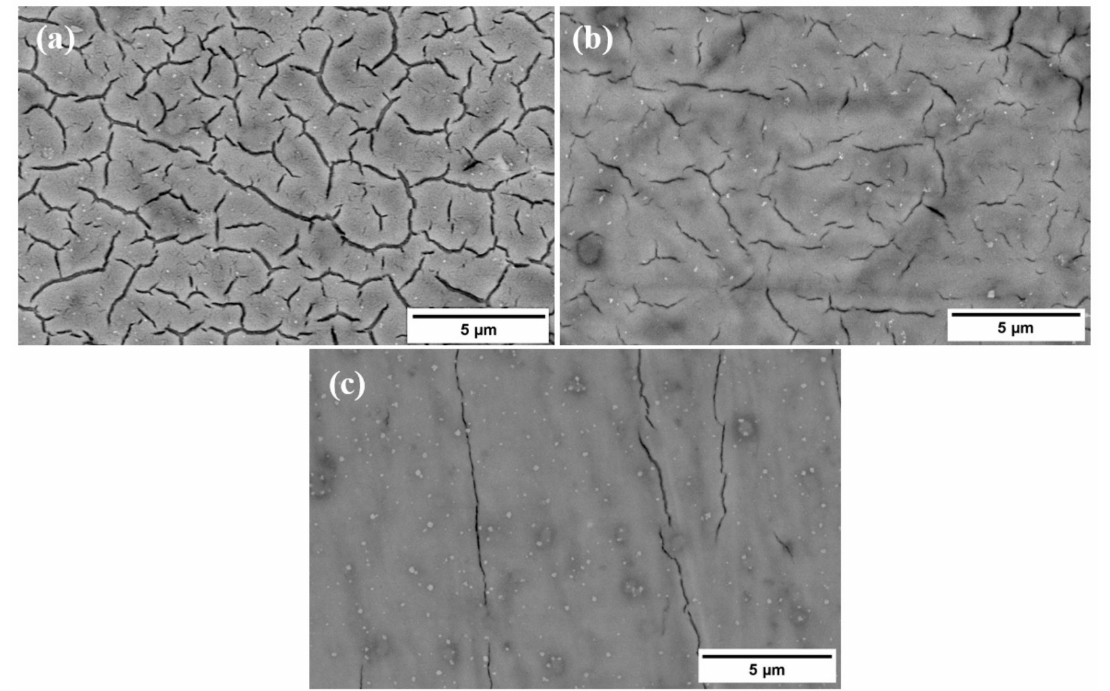
Figure 6. Microstructure of Ti-xTa substrates treated with 10 M NaOH at 20 k magnification—( a ) Ti-5%Ta; ( b ) Ti-15%Ta; ( c )